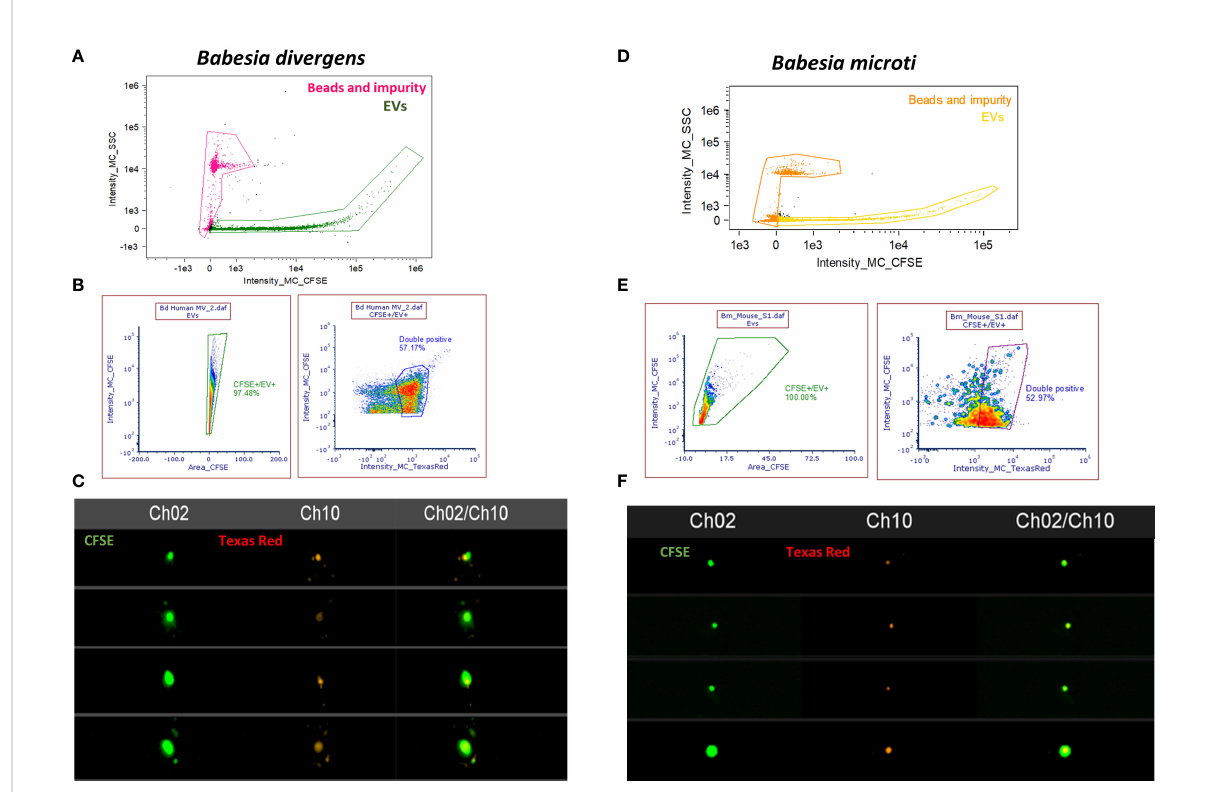
FIGURE 5 Imaging fl ow cytometry (IFC) – based quantitation of parasite-speci fi c extracellular vesicles (EVs). (A) Gating strategy to select for EVs from B. divergens – infected cells. Debris and beads were excluded from further analysis. The EVs were stained with carboxy fl uorescein succinimidyl ester (CFSE) (green) and Texas Red-Bd37, which is a B. divergens – speci fi c marker (red). (B) CFSE-positive cells were gated based on the area- versus-intensity plot. Right panel shows events that were positive for both CFSE and Texas Red-Bd37 and represent ~60% of EVs. (C) Images showing EVs that were labeled with both CFSE (Channel 2) and TR (Channel 10) and the merged image for the two channels. (D) Similar gating strategy as (A) was used to exclude beads and debris from EVs derived from B. microti – infected plasma. (E) EVs were stained with CFSE (green) and TR-Bm2 (red), which is a speci fi c marker of B. microti . CFSE+ cells were gated based on the area-versus-intensity plot. Right panel shows the events that were double positive for both (~50%). (F) IFC images showing EVs stained with CFSE (Channel 2) and TR (Channel 10) and their merged